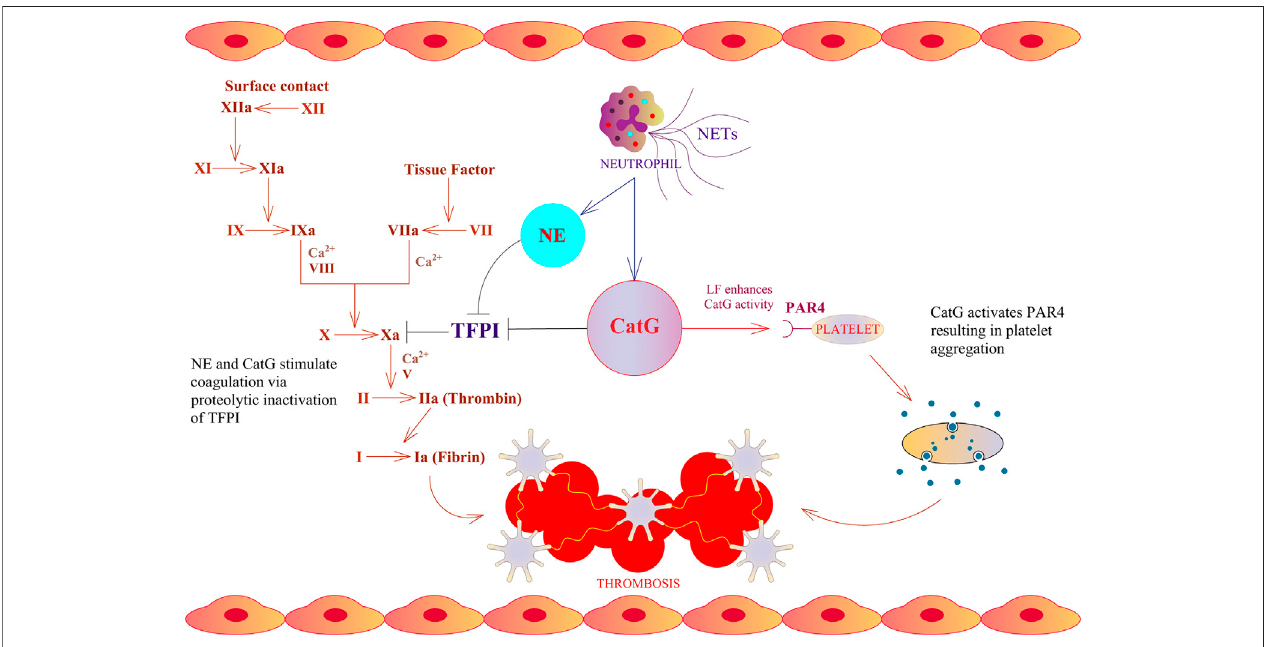
FIGURE 1 | Thrombosis cascade and CatG. NE and CatG stimulate coagulation via proteolytic inactivation of tissue factor pathway inhibitor (TFPI), which is an endogenous inhibitor of factor X. CatG is able to stimulate platelet aggregation via cleavage of protease-activated receptor 4 (PAR4).